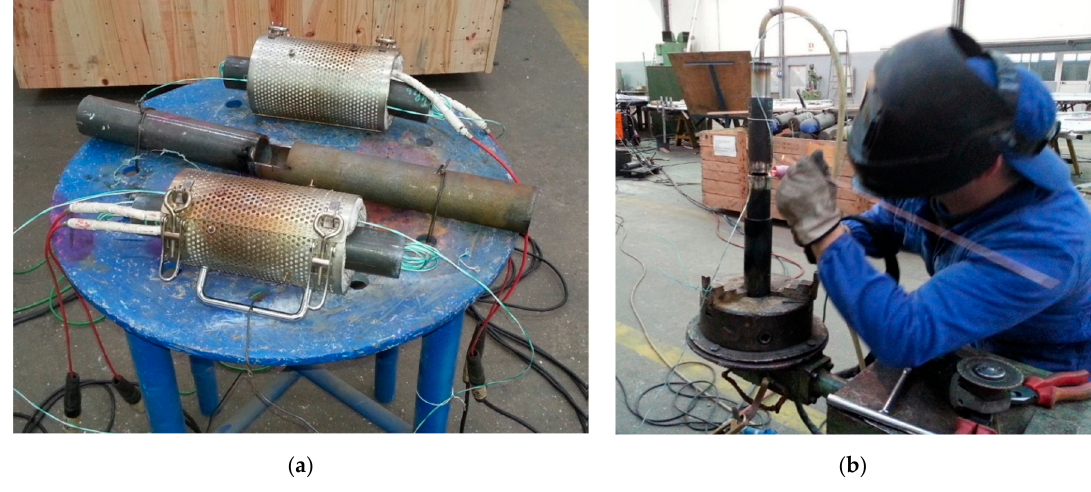
Figure 2. ( a ) Pipes preheating setup and ( b ) Pipe welding.